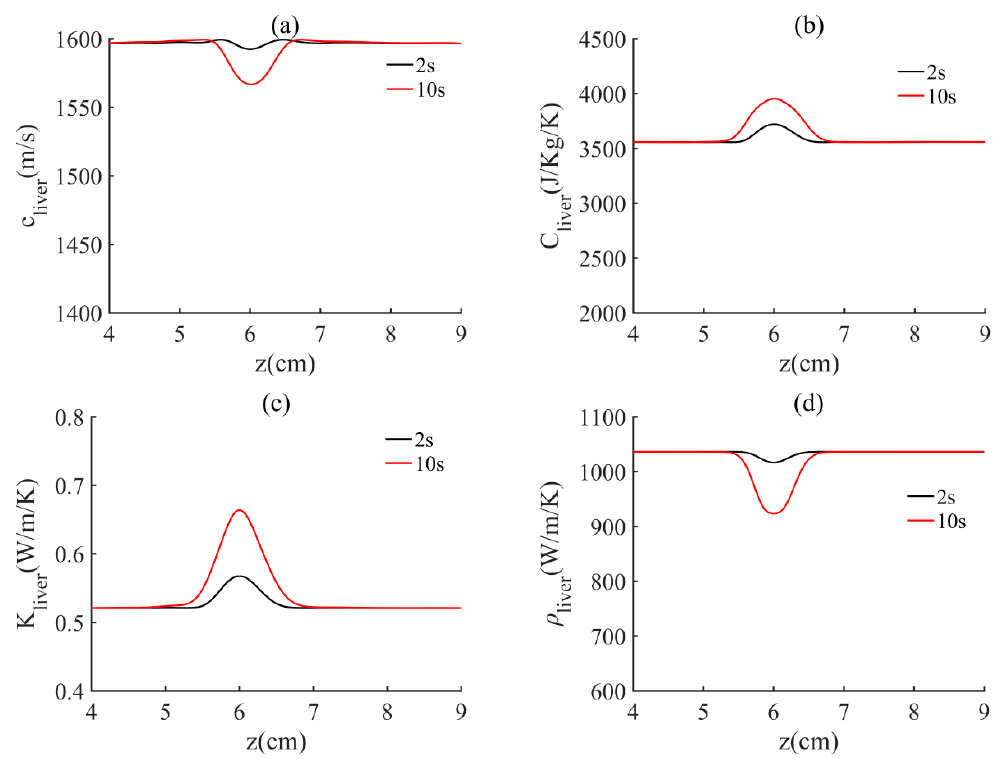
ρ at t = 2 s and 10 s. c ( b ) C ( c ) K ( d ) liver liver liver liver , and